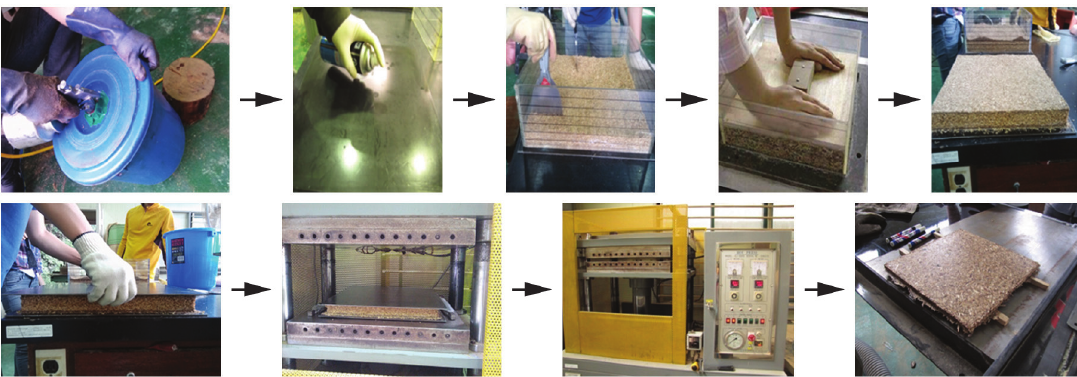
Figure 1. Laboratory-scale production of three-layer particleboards